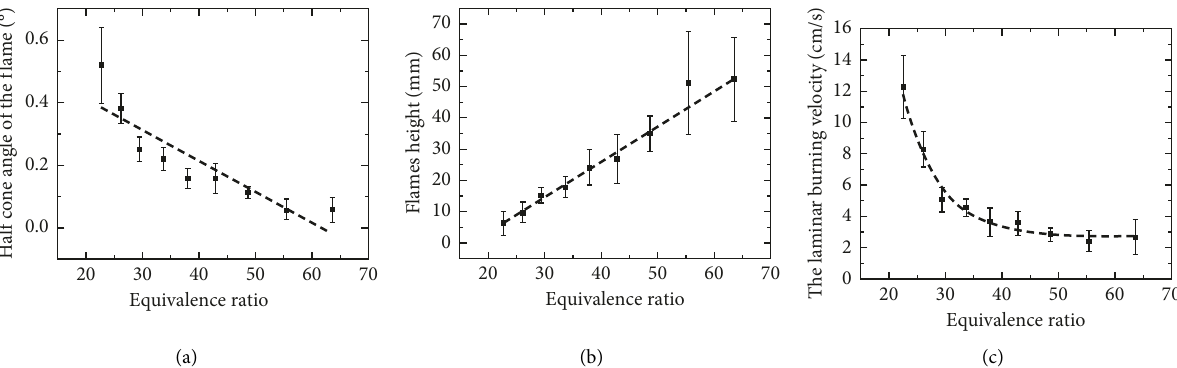
Figure 5: Flame parameters: half-cone angle of flame (a), flame height (b) and laminar burning velocity (S the Saudi LPG/air mixture mixed before the orifice